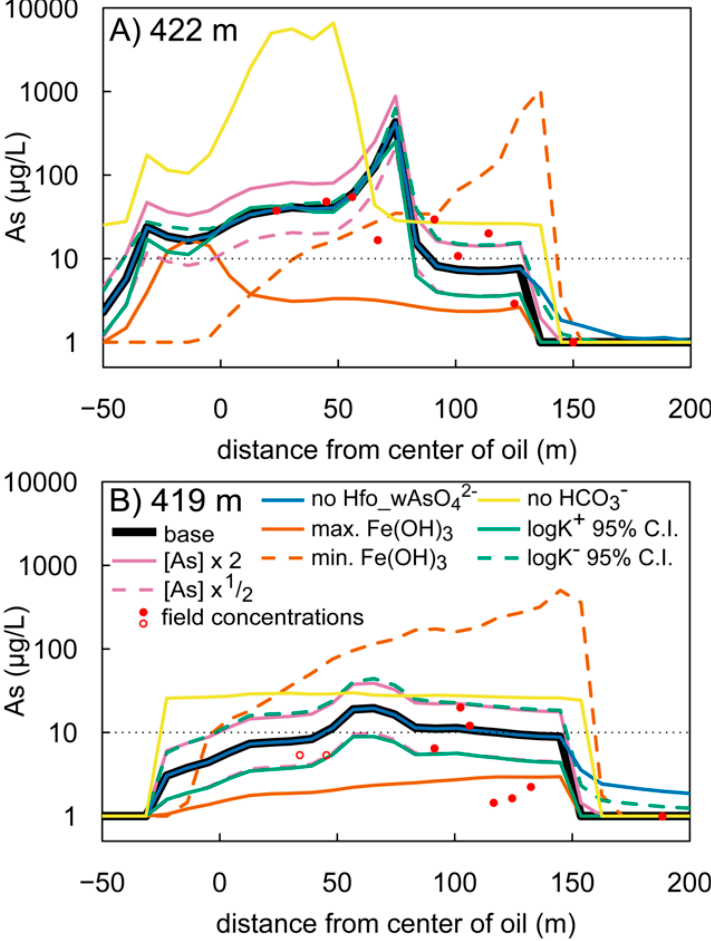
Figure 9. Concentration profiles for dissolved As at elevations of 422 m ( A ), and 419 m ( B ) for 37 years after the spill. Sensitivity scenarios shown include the model base case (black), doubled initial sorbed As (pink, solid), halved initial sorbed As (pink, dashed), upper 95% confidence interval (C.I.) for intrinsic As surface complexation constants (green, solid), lower 95% C.I. for intrinsic As surface complexation constants (green, dashed), maximum measured (orange, solid) and minimum measured (orange, dashed) background Fe(OH) 3 concentration, no complexation of HCO 3 − (gold), and omission of an As(V) surface complexation reaction (Reaction 9 in Table 1) (blue). Field measured As concentrations shown in red circles are from [29]. Open circles designate samples <10 µg/L and are plotted at half the detection limit. Note that the y-axes are on the logarithmic scale.